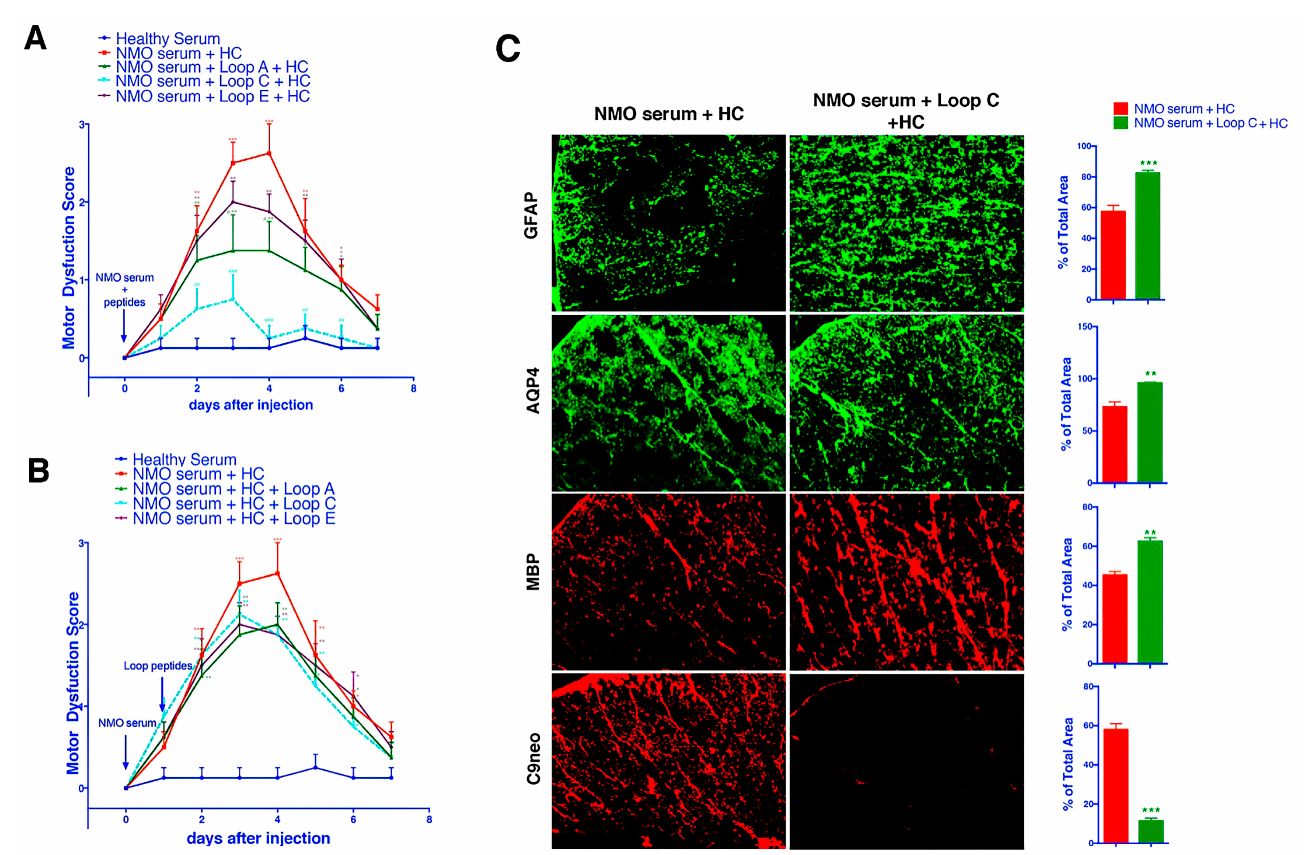
Figure 3. AQP4 extracellular loop mimotope peptides reduced AQP4-IgG-regulated complement cytotoxicity. ( A ) Pretreatment (injected together) with the Loop C mimotope alleviated the motor dysfunction induced by AQP4-IgG plus complement. ( B ) Post-treatment (injected Loop C mimotope 24 h later) failed to reduce the motor dysfunction score. *, **, and *** represent p < 0.05, p < 0.01, and p < 0.001, respectively, when compared with the healthy serum group. #, ##, and ### represent p < 0.05, p < 0.01, and p < 0.001, respectively, when compared with the NMOSD serum group. ( C ) Immunofluorescence staining indicated that the reduction in astrocyte (GFAP and AQP4) and myelin sheath (MBP) was inhibited when AQP4-IgG was precipitated by treatment with the Loop C mimotope peptide, which also reduced the complement